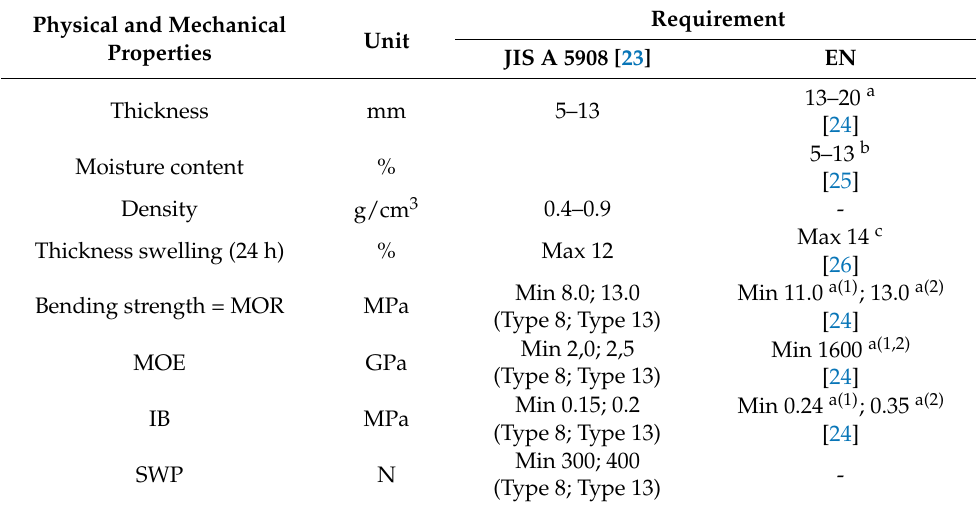
Table 1. Minimum requirements for particleboards based on national and international